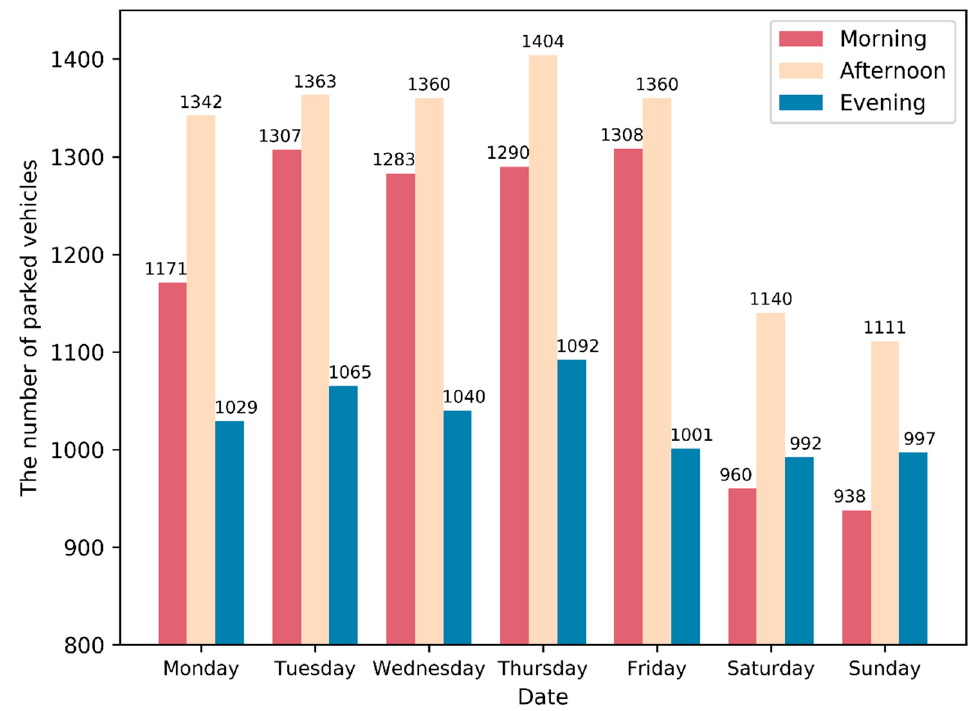
Figure 4. The number of parked vehicles in the morning, afternoon, and evening on each day of the week.